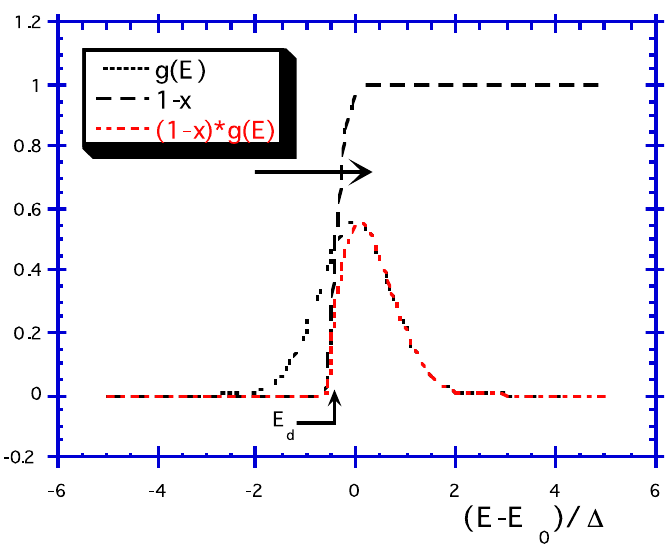
Figure 25. Reaction progresses by removing B sites, from less stable to the most stable